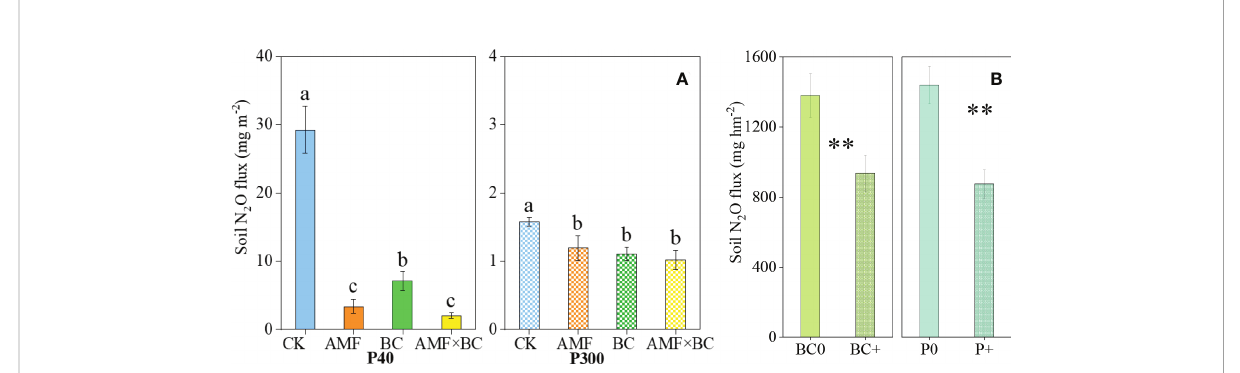
FIGURE 3 (A) Variation in the cumulative emissions of N2O as in fl uenced by P rates (40 and 300 mg kg − 1 soil) and AMF and BC additions in the greenhouse experiment. Each value is the mean of fi ve replicates (±SE). For a given P rate, different letters in each graph denote signi fi cant difference among treatments. (B) Variation in the cumulative emissions of N 2 O as in fl uenced by P and BC additions in fi eld experiment. Each value is the mean of four replicates (±SE). ** P <